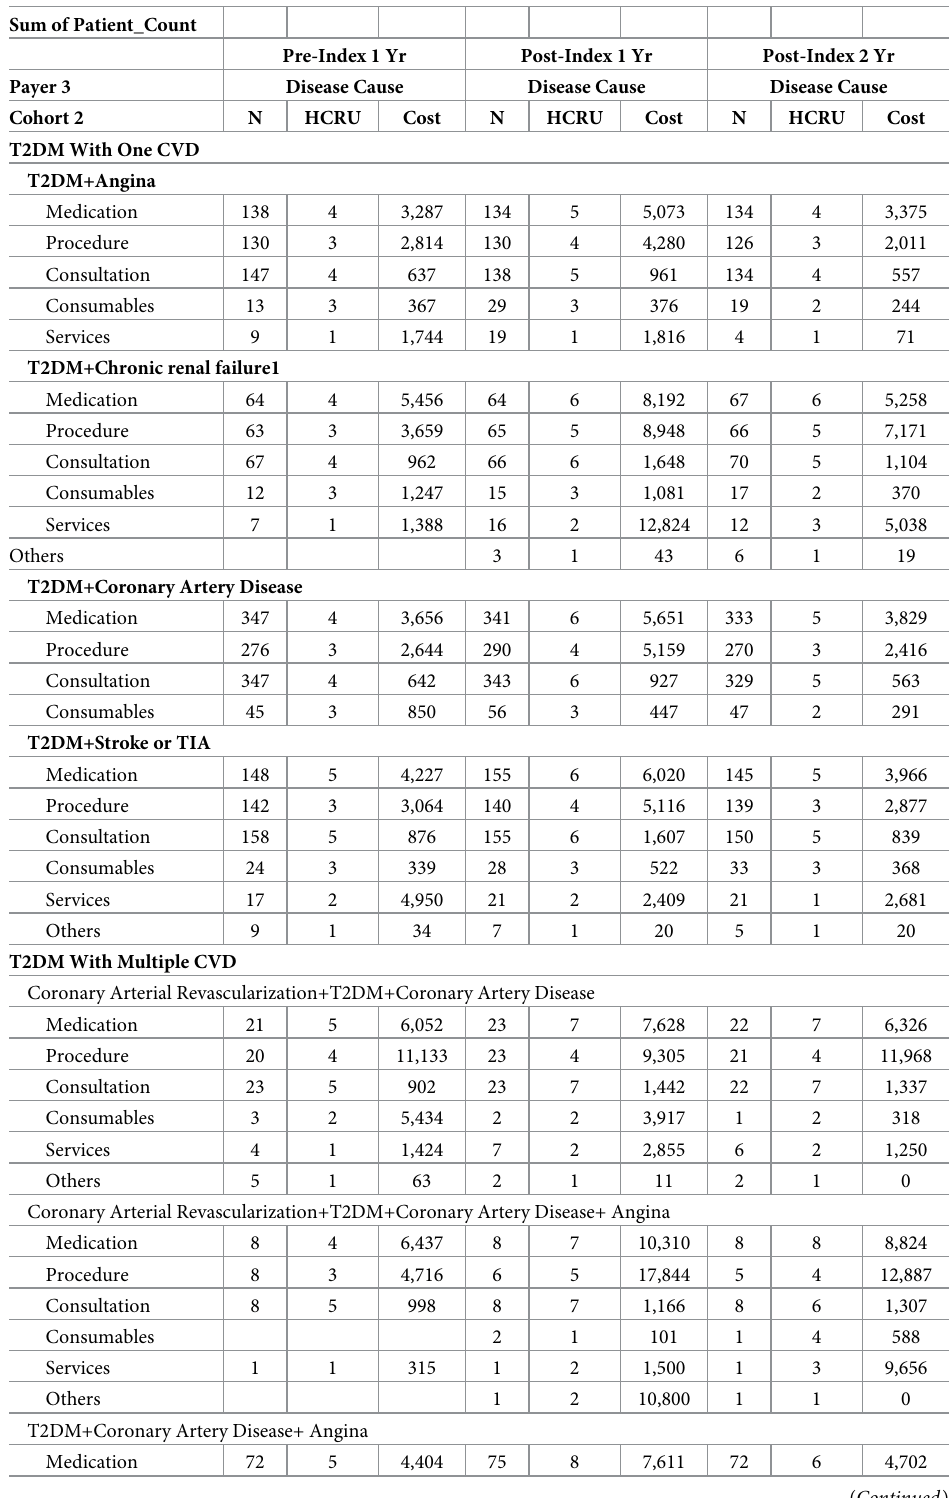
Table 4. HCRU disease-specific claims and costs for various activities during 2-year follow-up period (Payer 3, Cohort